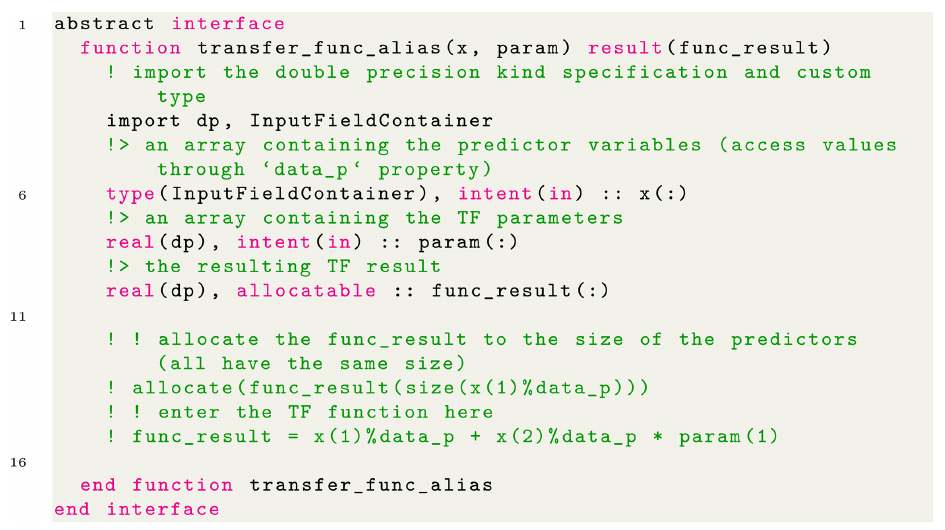
Figure D1. Template for user-defined TFs as an abstract interface.